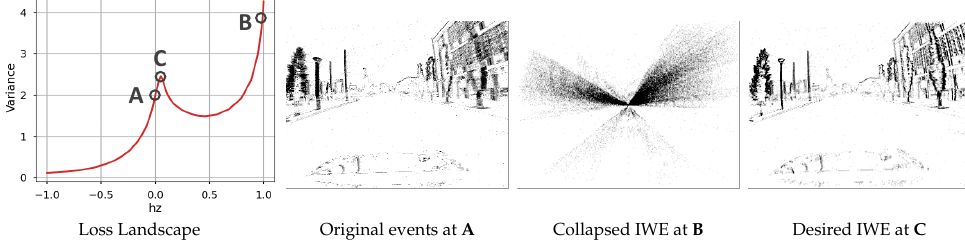
Figure 1. Event Collapse. Left : Landscape of the image variance loss as a function of the warp parameter h z . Right : The IWEs at the different h z marked in the landspace. ( A ) Original events (identity warp), accumulated over a small ∆ t (polarity is not used). ( B ) Image of warped events (IWE) showing event collapse due to maximization of the objective function. ( C ) Desired IWE solution using our proposed regularizer: sharper than ( A ) while avoiding event collapse ( C